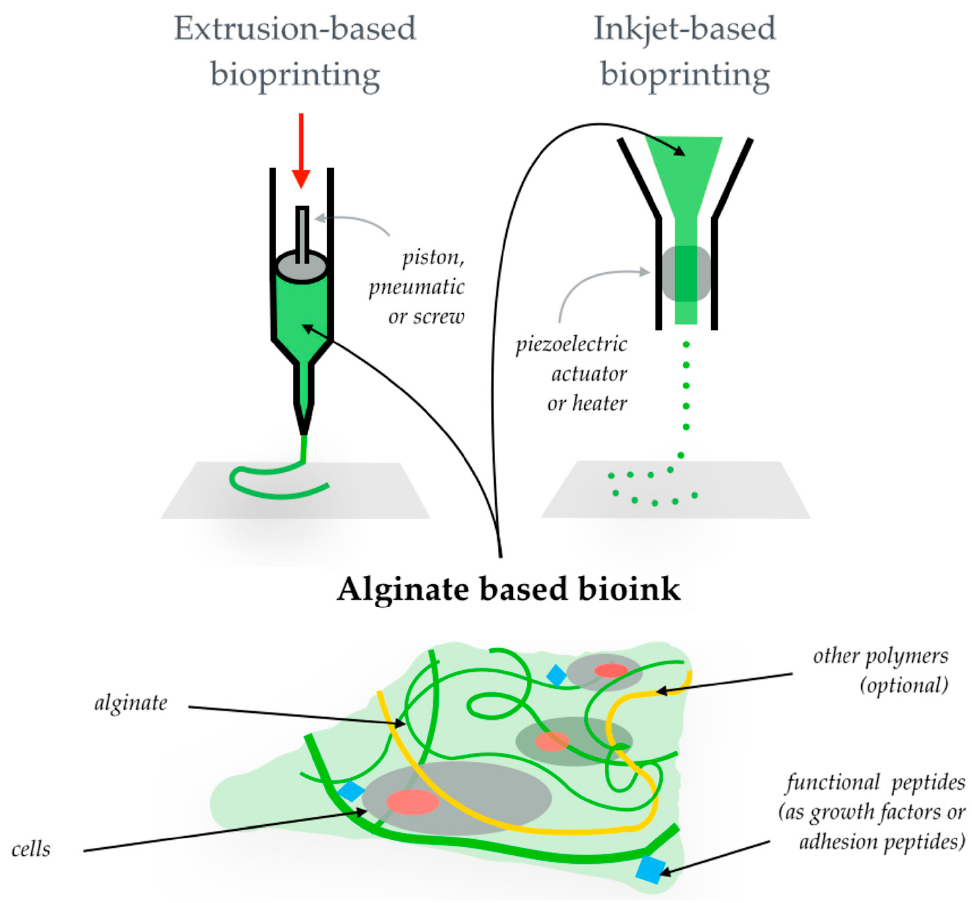
Figure 3. Bio-printing techniques used to obtain an alginate-based 3D-hydrogel. Re-adapted from Axpe, E.; Oyen, M.L. Applications of alginate-based bioinks in 3D bioprinting. Int. J. Mol. Sci. 2016 , 17 , 1976. https://doi.org/10.3390/ijms17121976 [145]. Table 1. Summary of the main properties of alginate conjugates, techniques employed in their manufacture and related advantages for corneal tissue engineering.